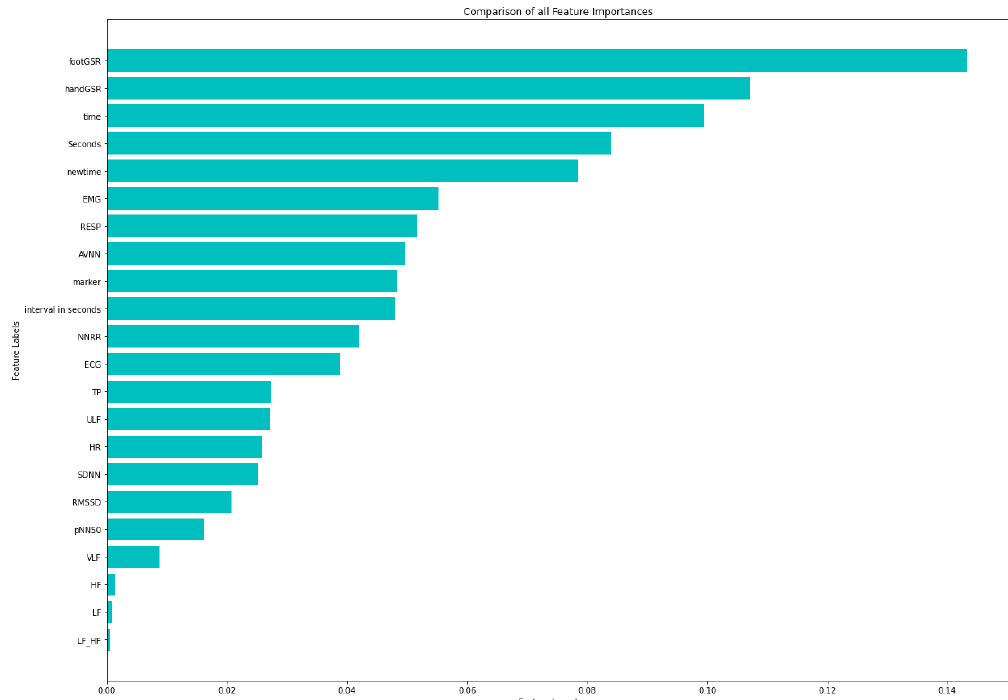
Figure 3. Heat map plot of Pearson’s Correlation Feature Selection performed on original-dataset.